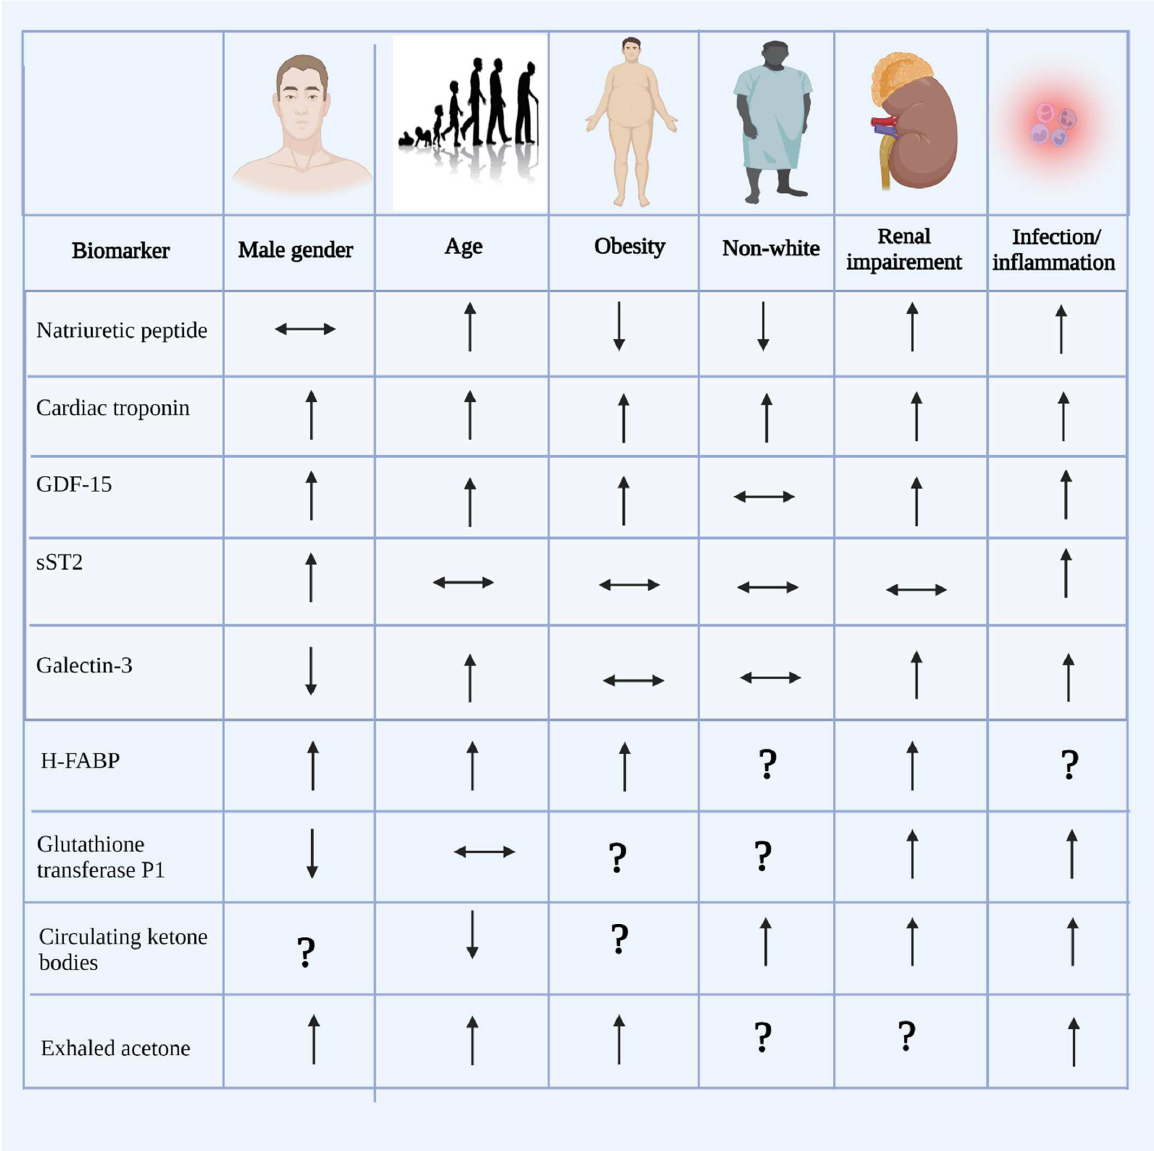
Figure 2. Effects of confounders on biomarker level. GDF-15—growth differentiation factor-15; sST2—soluble suppression of tumorigenicity 2. H-FAB—Heart-Type Fatty Acid-Binding Protein. Factors increasing (arrow facing up) and decreasing (arrow facing down) biomarker levels. Unchanged biomarker levels are shown by an arrow facing both ways. An unknown effect on biomarker level is shown by a question